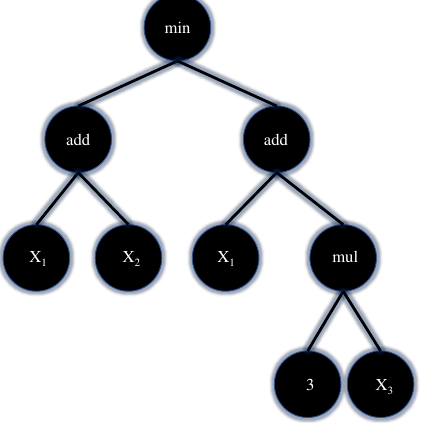
Figure 4. GP syntax tree representing y = min ( X 1 + X 2 , X 1 + 3 · X 3 )